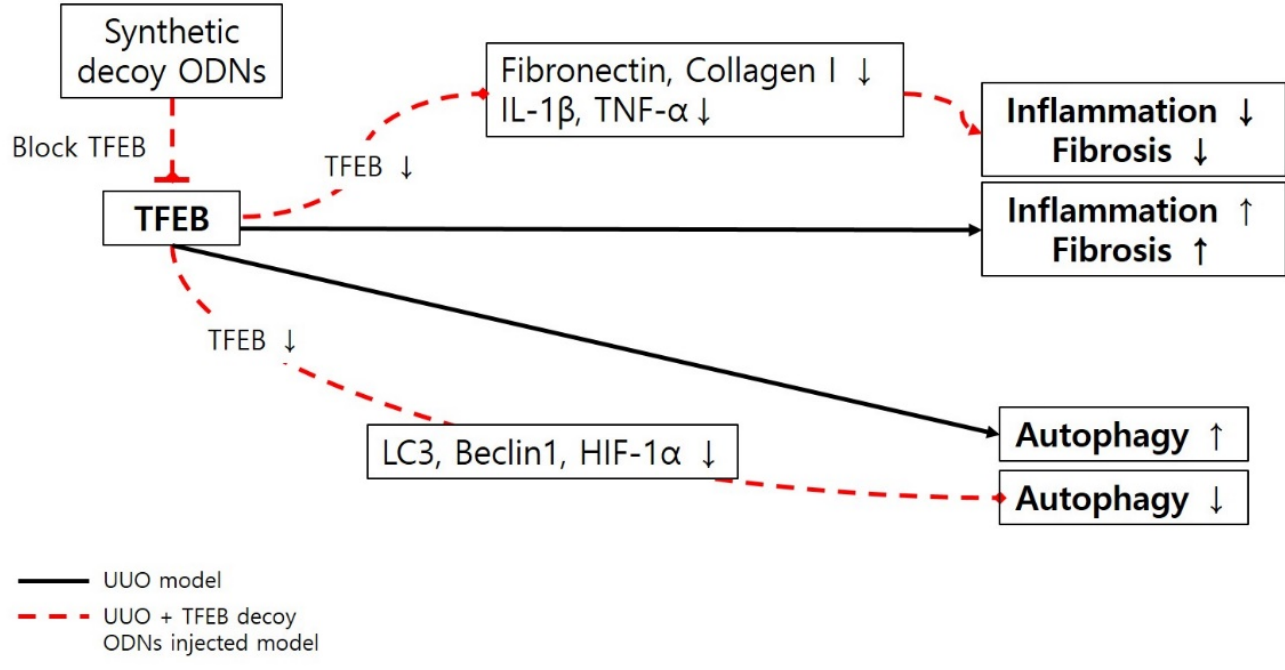
Figure 5. Schematic diagram of the molecular pathway for TFEB transcription factor and inhibitory effects of synthetic decoy ODNs on autophagy in renal injury UUO, unilateral ureteral obstruction; decoy ODNs, decoy oligonucleotides; TFEB, Transcription factor EB; IL-1 β , interleukin-1 β ; TNF- α , tumor necrosis factor- α ; LC3, microtubule-associated protein light chain 3; HIF-1 α , hypoxia inducible factor-1 α .